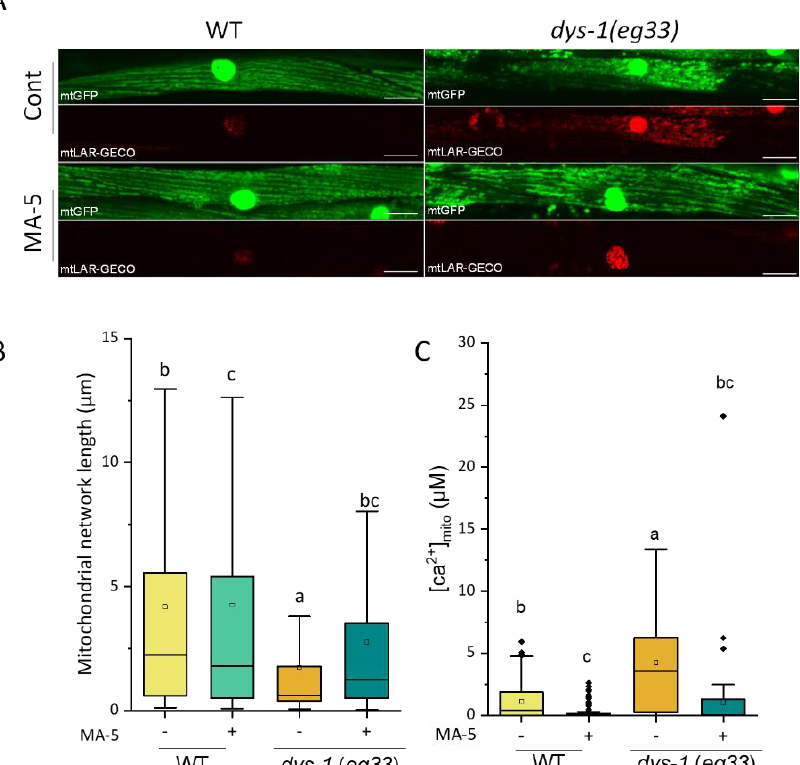
Figure 3. MA-5 suppressed DMD disease model symptoms on mitochondrial fragmentation and mitochondrial Ca 2+ levels increase. ( A ) Representative images of the mitochondrial morphologies (indicated as green), mitochondrial calcium signal (indicated as red) and merged observed. (Scale bar: 20 µ m). Transgenic C. elegans dys-1(eg33) null mutant ATU3305 expressing mitochondria-targeted GFP (mtGFP) and mitochondrial calcium-targeted LAR-GECO (mtLAR-GECO) in body wall muscle cells were monitored on day 2 of adulthood. ( B ) The mitochondria network length in each muscle cell ( n ≥ 900 mitochondria from 5–7 worms/treatment) treated with or without MA-5 of 2-day-old ATU3305 adults. Different letters indicate significant differences ( p ≤ 0.05) by Dunn’s test. ( C ) Concentration of mitochondrial calcium in worms ( n ≥ 60 from 6–12 worms/treatment). Different letters indicate significant differences ( p ≤ 0.05) by Dunn’s test with all data points including outliers. Data are shown as box plots to indicate median (central line) and mean (square mark). Cont: control treated with 0.1% DMSO; MA-5: 10 µ M; WT: wild type (strain ATU3301); Diamond mark: outlier